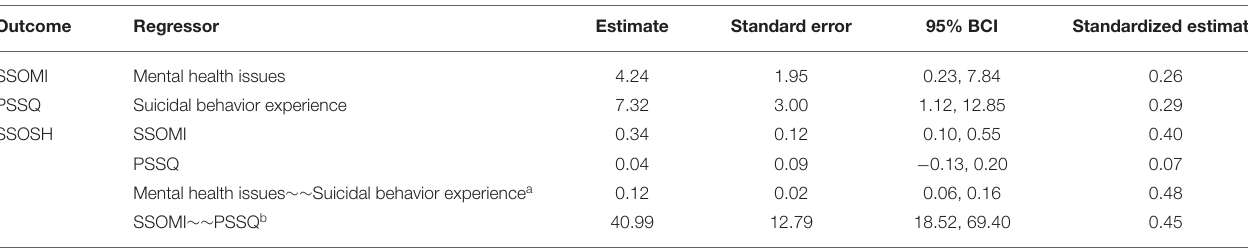
TABLE 3 | Regression coefficients in the tested